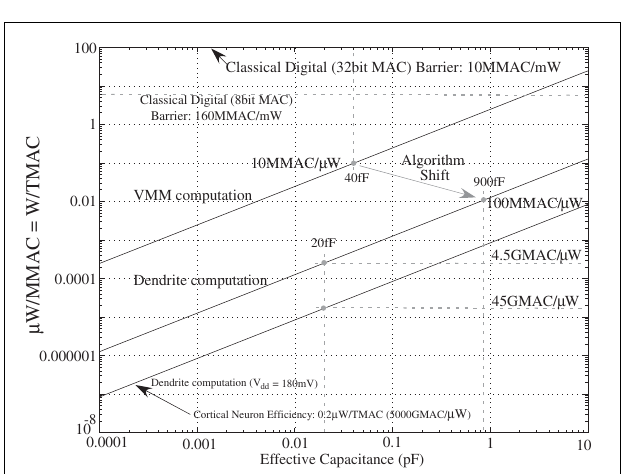
FIGURE 20 | Plot of computational efficiency versus capacitance level for VMM (analog) and Dendrite computation (neuromorphic, wordspotting) physical algorithms for V dd = 2 . 5V. For both algorithms, the efficiency improves linearly with decrease in V dd , since power scales linearly with V dd here. We also show the computational efficiency for the dendrite computation for V dd = 180mV, typical of neurobiological systems (Siwy et al., 2003). We also include a table of effective SNR, computed from thermal noise at the node over signal size ( ≈ U T ), as a function of